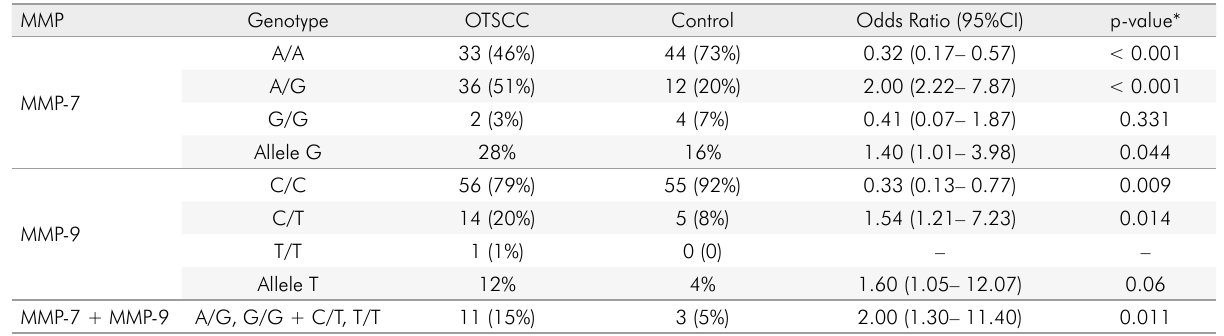
Table 2. Distribution of MMP-7 and -9 genotypes in OTSCC and controls. MMP